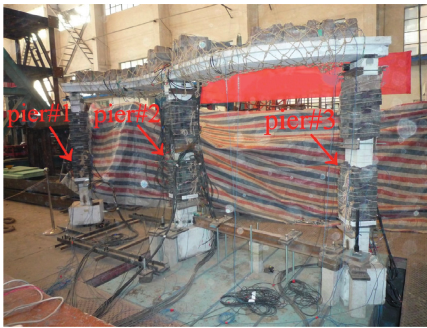
Figure 2: Experimental